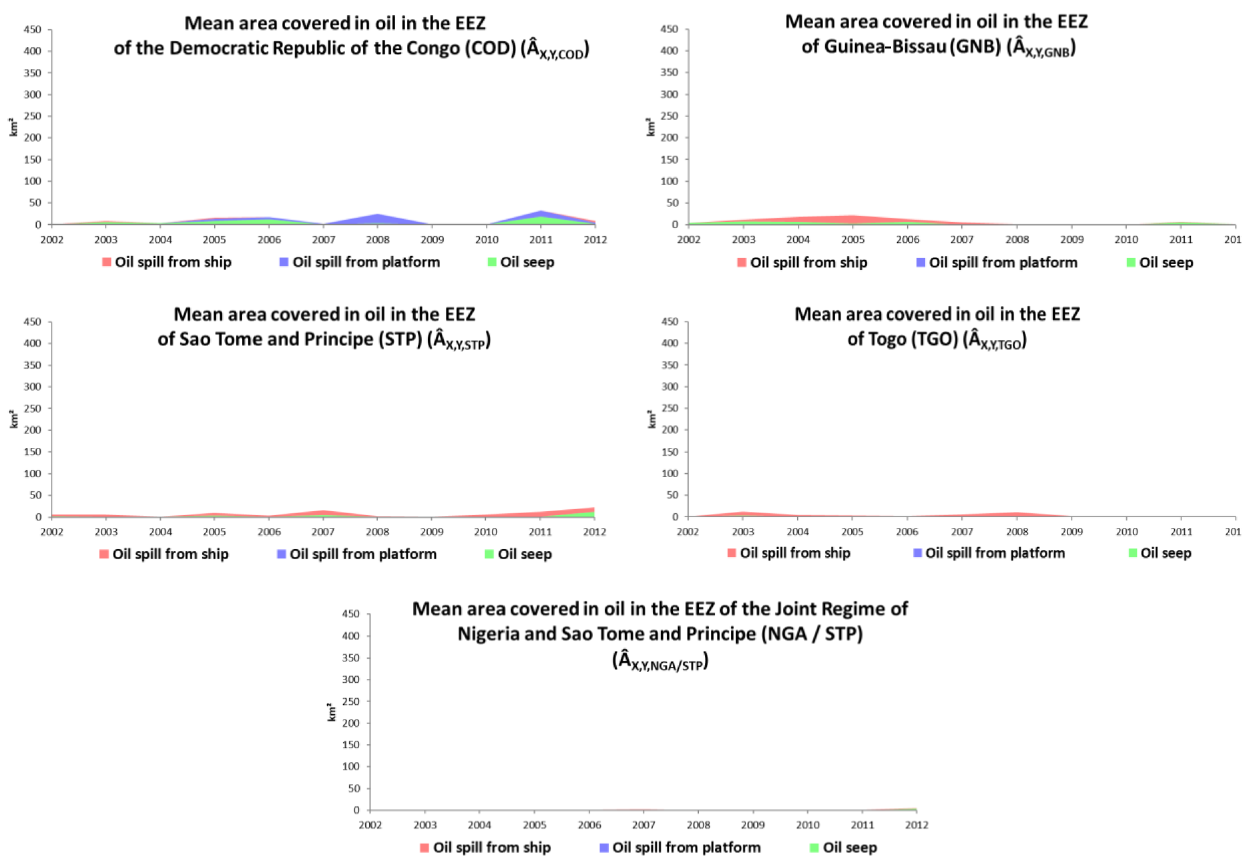
Figure 17. Mean area covered in oil by EEZs of countries per year (Â X,Y, EEZ ).